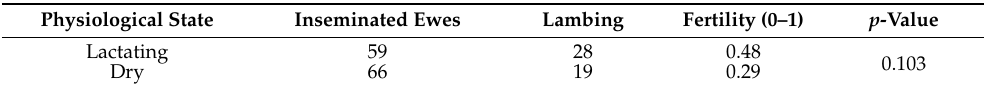
Table 4. Physiological state and fertility of organic Churra ewes in Spain. Physiological State Inseminated